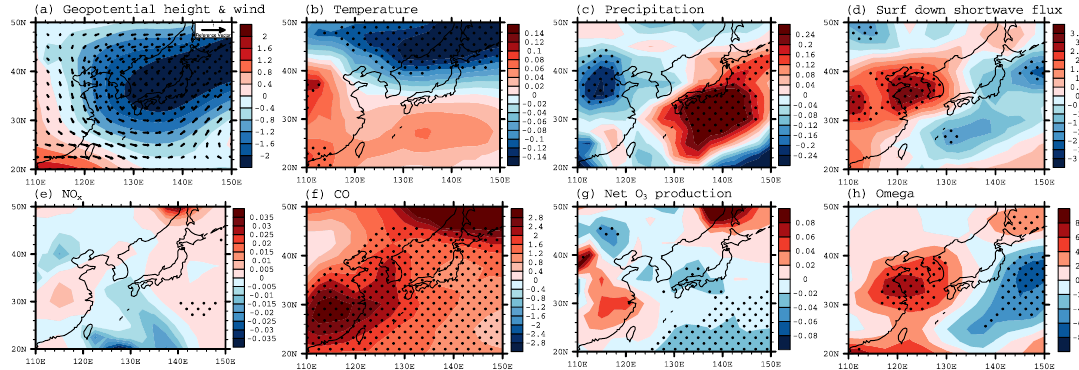
Figure 6. TheregressionfieldsbetweenPC1fromtheEOFanalysisofdetrendedozoneand( a )geopotential height (shaded; m) and horizontal wind (vector; m s − 1 ), ( b ) temperature (K), ( c ) precipitation (mm day − 1 ), ( d ) surface downwelling shortwave flux (W m − 2 ), ( e ) nitrogen oxides (ppbv), ( f ) carbon monoxide (ppbv), ( g ) net ozone production rate ( × 10 − 12 mole m − 3 s − 1 ), and ( h ) 500 hPa omega (hPa day − 1 ) during summer. Note that all variables except ( c , d , h ) are for an 850 hPa level. Black dots indicate statistical significance at 90% confidence level using a Student’s